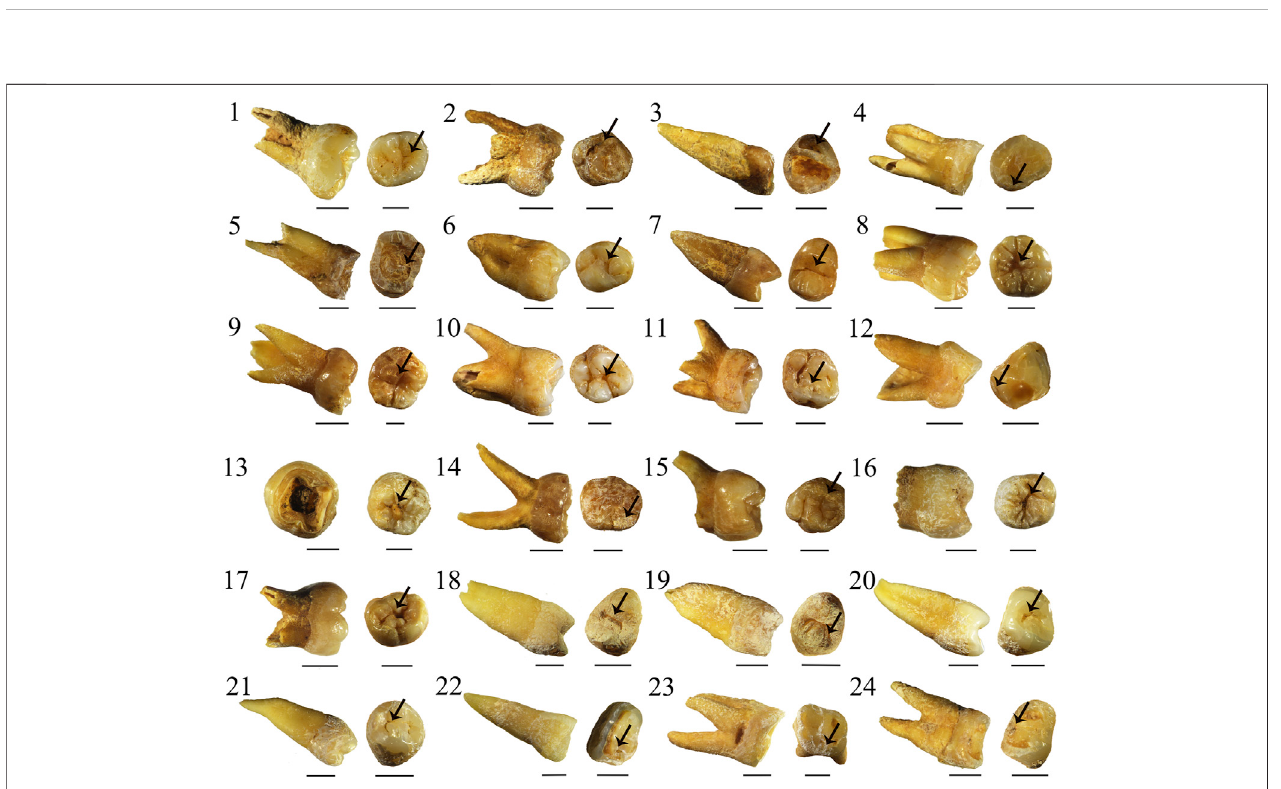
FIGURE 2 | Twenty-four human teeth from seven individuals from the house foundations and tombs of the Lajia site in Qinghai Province. (1,2) belong to the F4 II humanskull; (3-5) belongtotheF4 IIIhumanskull; (6-9) belongtotheF4 Vhumanskull; (10 – 12) belongtotheF4X humanskull; (13 – 17) belongtotheF7 Ihumanskull; (18 – 21) ,belongtotheM8humanskull; (22 – 24) belongtotheM11humanskull. (1 – 24) lateralandfrontalviewsofeachtooth.Blackarrowsshowthesamplinglocations. (Scale bar: 5 mm).